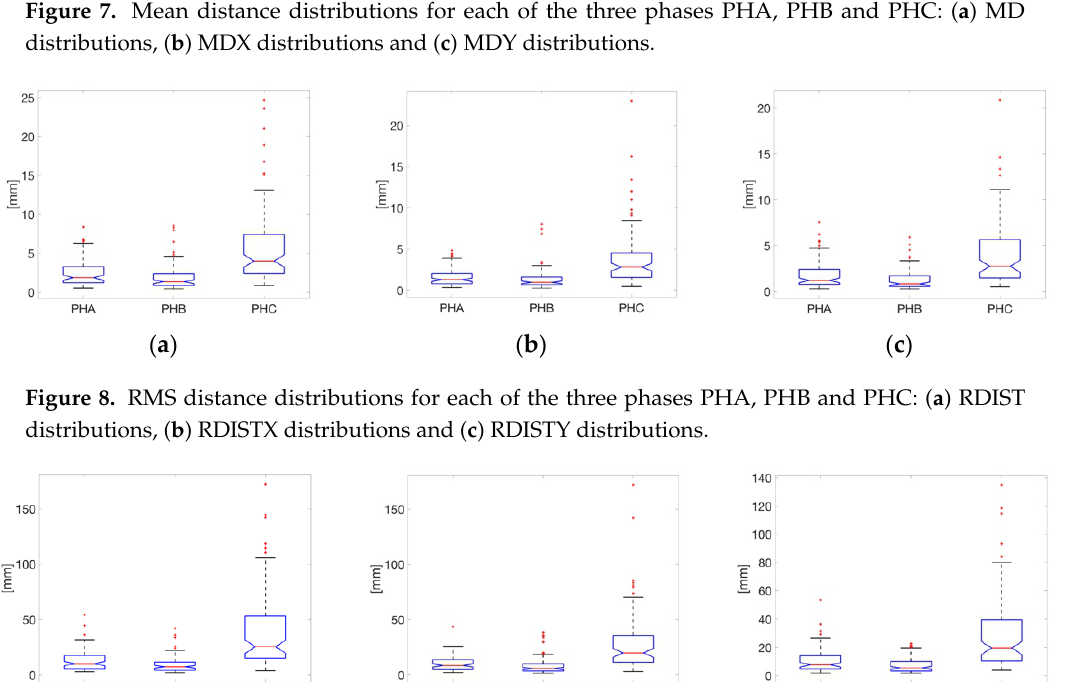
( c ) Figure 10. Mean velocity distributions for each of the three phases PHA, PHB and PHC: ( a ) MVELO distributions, ( b ) MVELOX distributions and ( c ) MVELOY distributions. Finally, area parameters distributions (Figure 11) reveal a larger area swept by the UCOP trajectory and a general instability achieved by subjects in PHC than in PHA and PHB, especially considering the 95% confidence circle and ellipse areas.